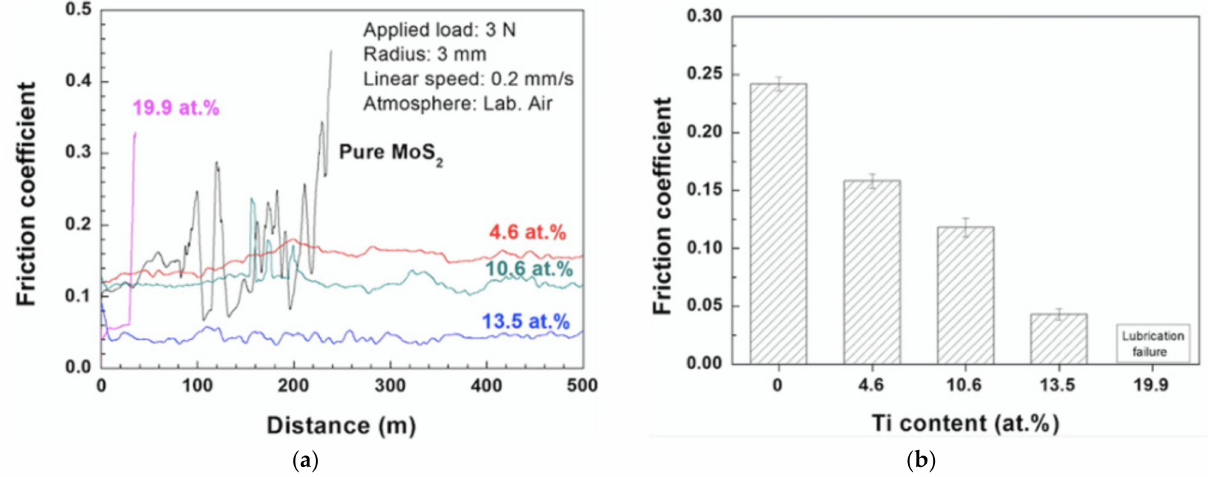
Figure 11. ( a ) Sliding friction curve and ( b ) mean coefficient of friction as a function of Ti content for sputter-deposited Ti/MoS 2 films